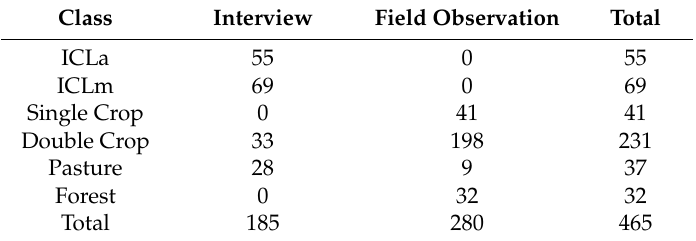
Table 1. Number of field data/points collected by interviews and field observation, for 2016. Class Interview Field